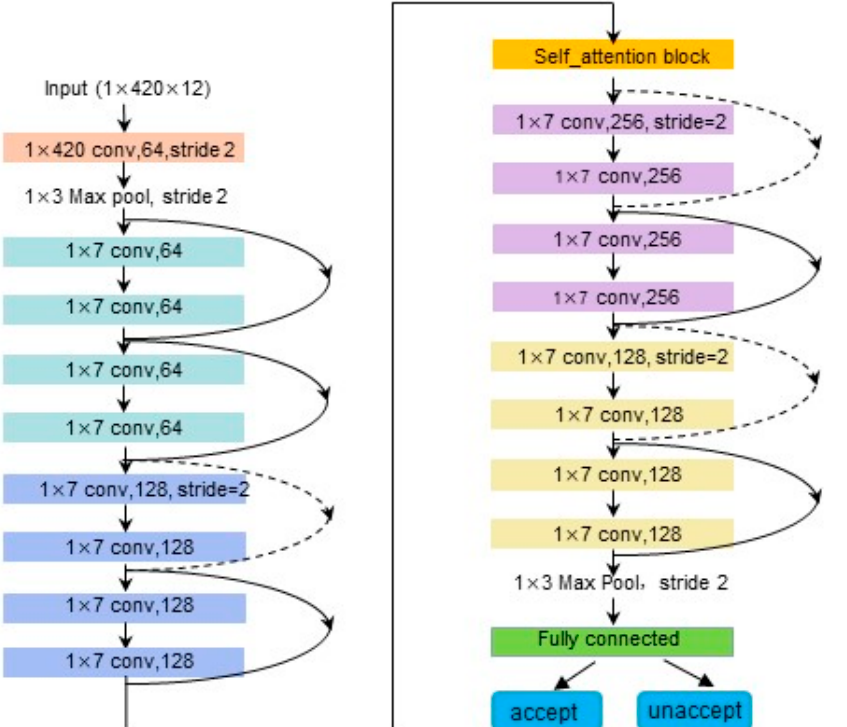
Figure 1. Structure diagram of the signal quality assessment model.